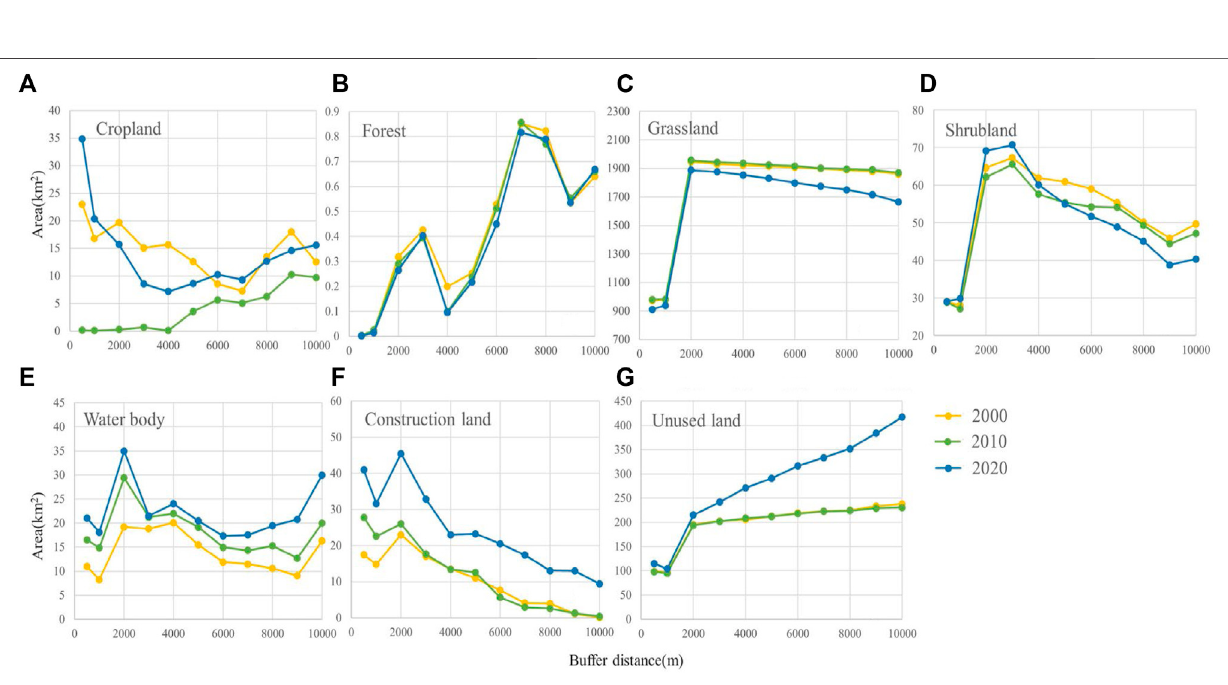
Frontiers in Environmental Science |